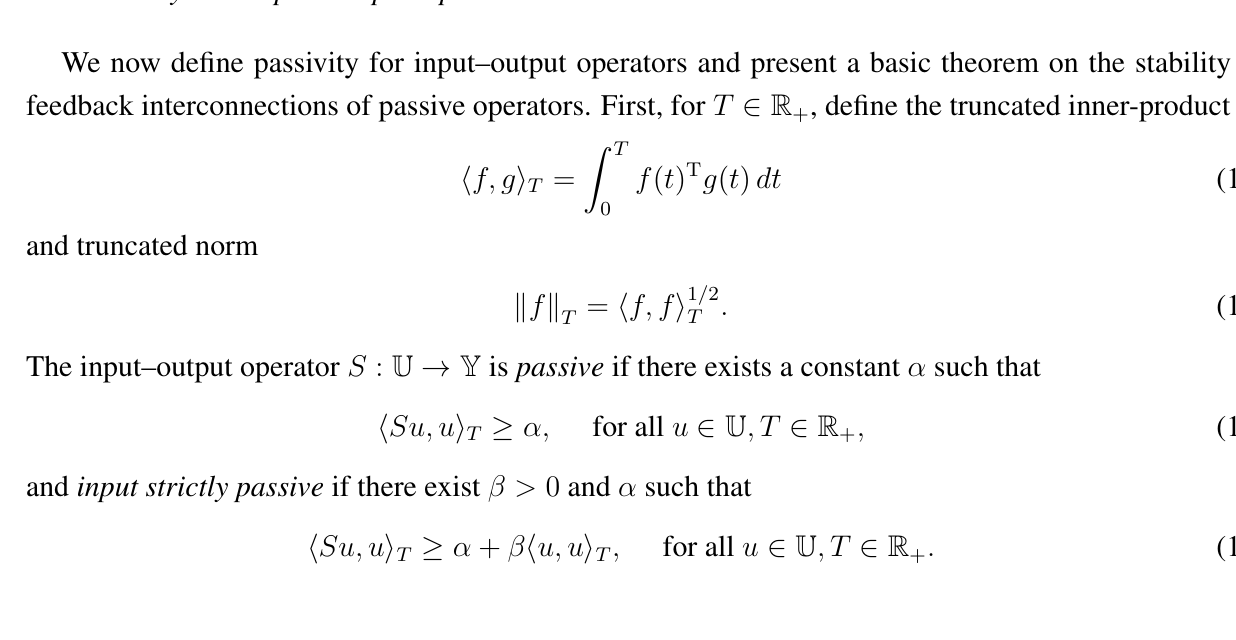
Figure 2a represents a feedback interconnection of two input–output operators, S